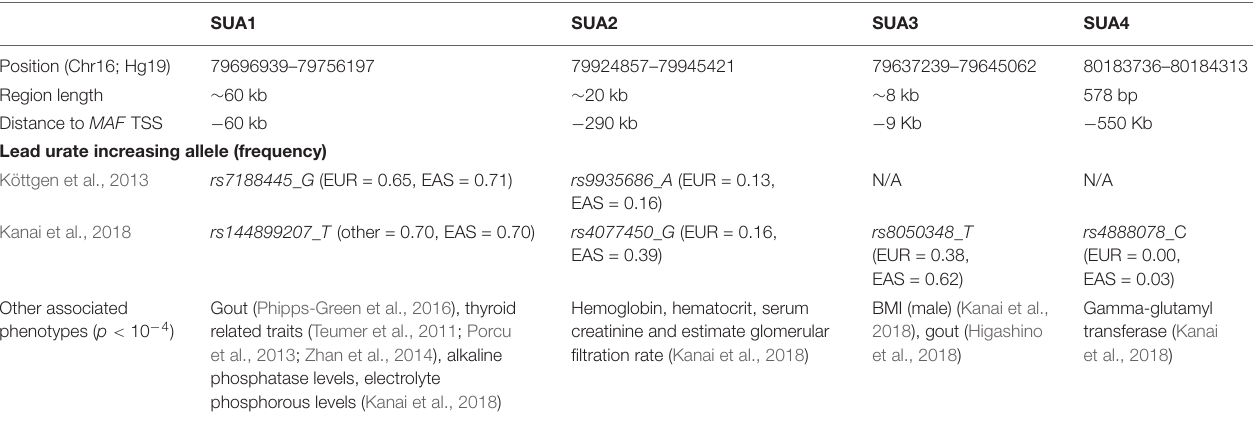
TABLE 1 | Serum urate associated regions upstream of